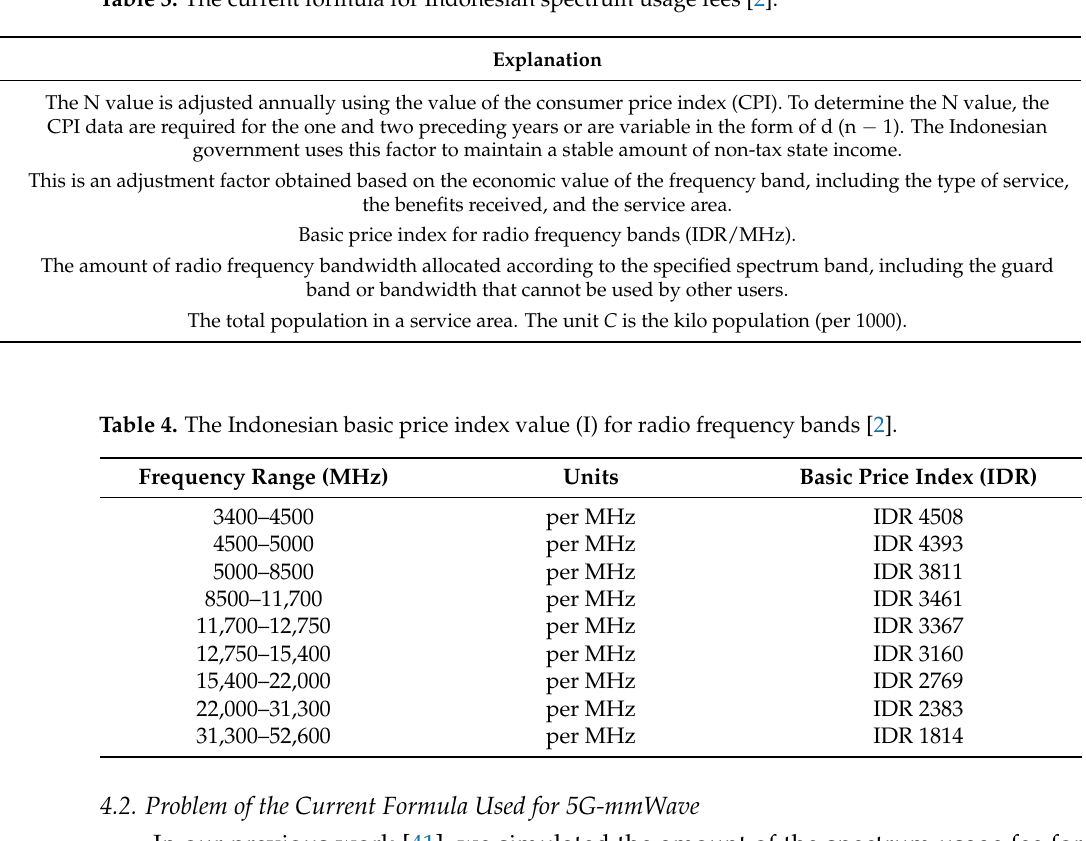
Table 3. The current formula for Indonesian spectrum usage fees [2].